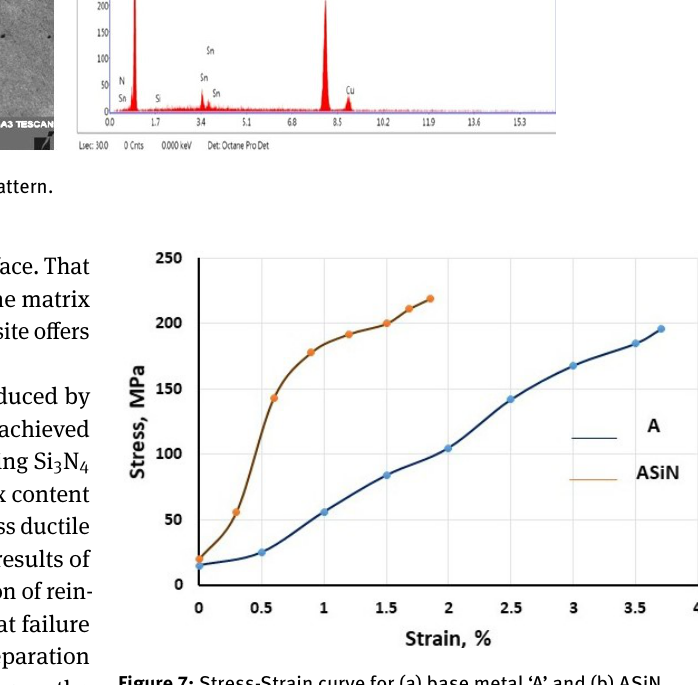
Figure 7: Stress-Strain curve for (a) base metal ‘A’ and (b) ASiN reinforced